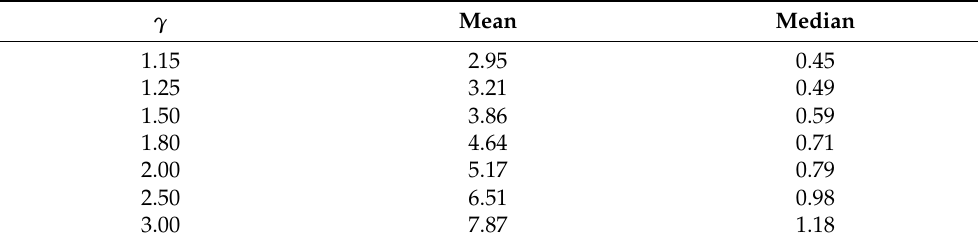
Table 2. Mean and median proportional absolute error of β estimates compared to centralized setting, over γ after five iterations for ε = 1.